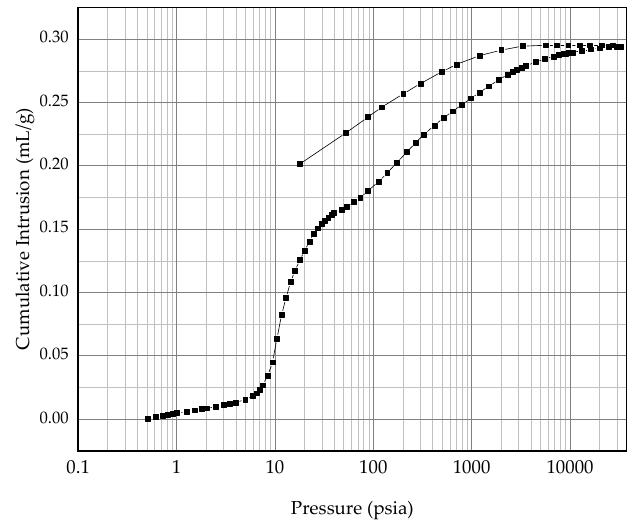
Figure 15. Three mercury injection–mercury removal curve of soil sample.